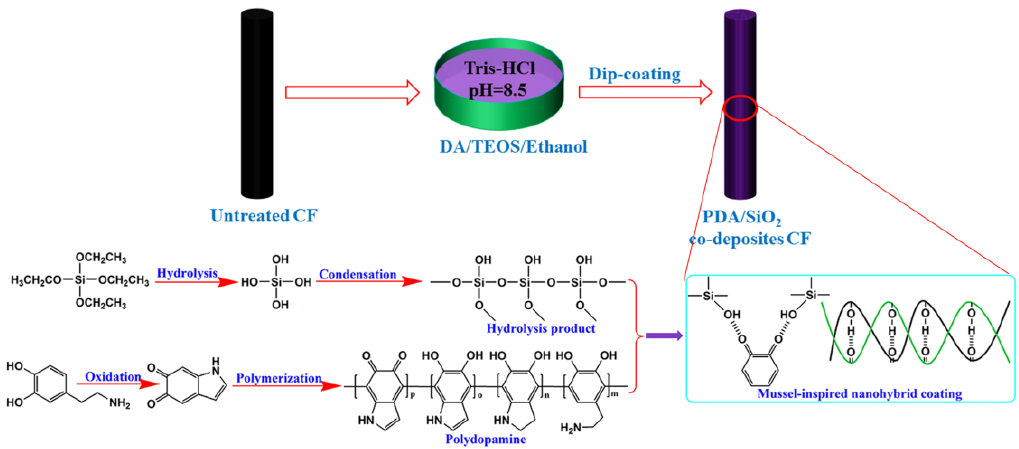
Figure 1. The schematic illustration for the immobilization of PDA/SiO 2 nanohybrid coatings onto the fiber surface.